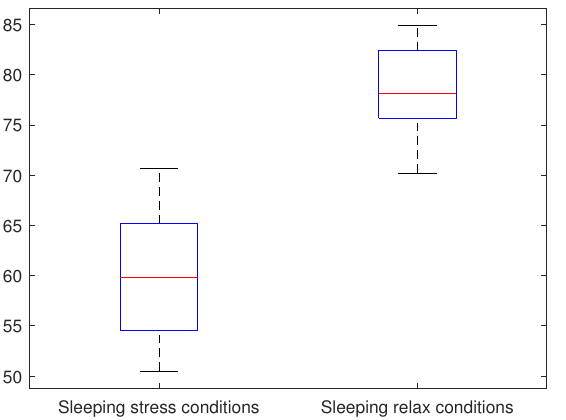
Figure 21. Box plot of the sleep rhythm per person under stress and relaxation conditions through the sensor